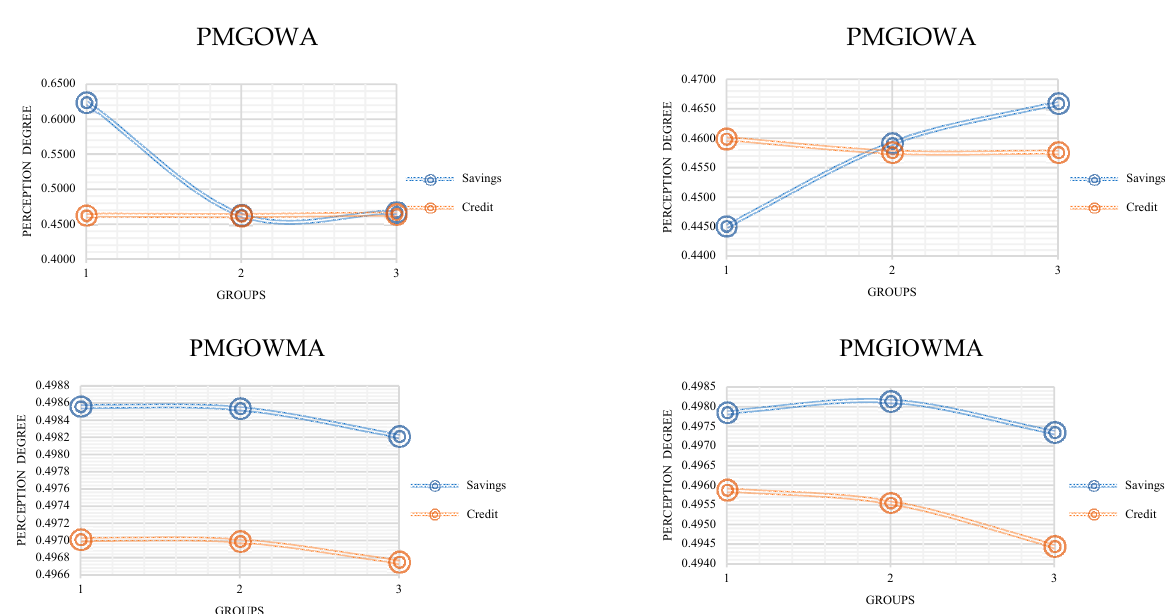
Figure 2. Perceptions of savings and credit by each method.